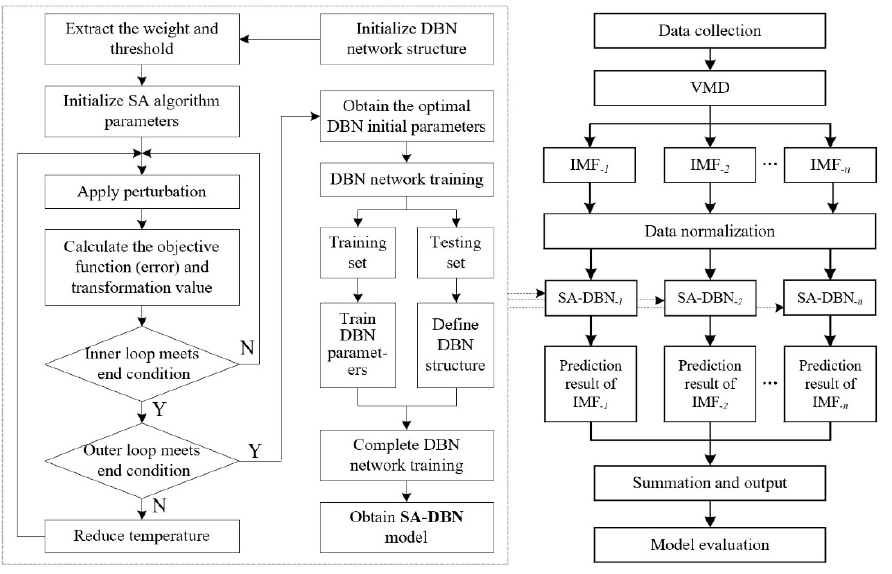
Figure 3. VMD ‐ SA ‐ DBN model framework. Figure 3. VMD-SA-DBN model